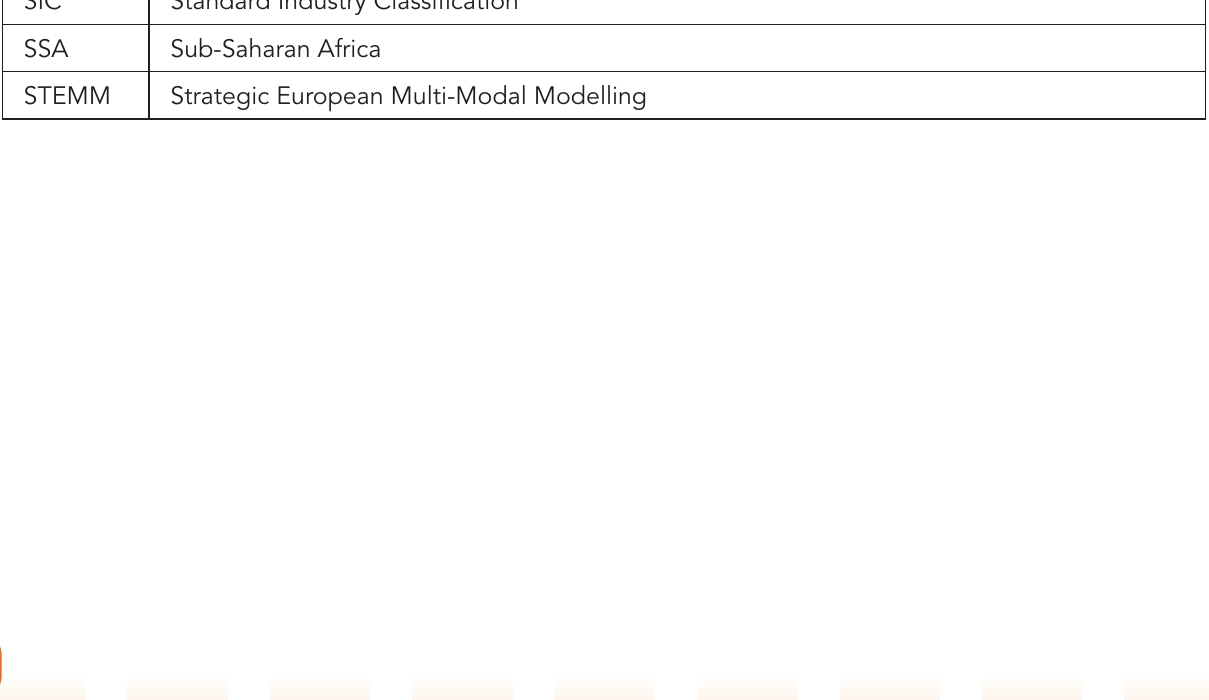
CPI Consumer Price Index DRC Democratic Republic of Congo EU European Union FDM Freight Demand Model FP Framework Programme HS-4 Harmonized System 4 digit ITC International Trade Centre OECD Organisation for Economic Co-operation and Development RDT Research and Technological Development SIC Standard Industry Classification SSA Sub-Saharan Africa STEMM Strategic European Multi-Modal